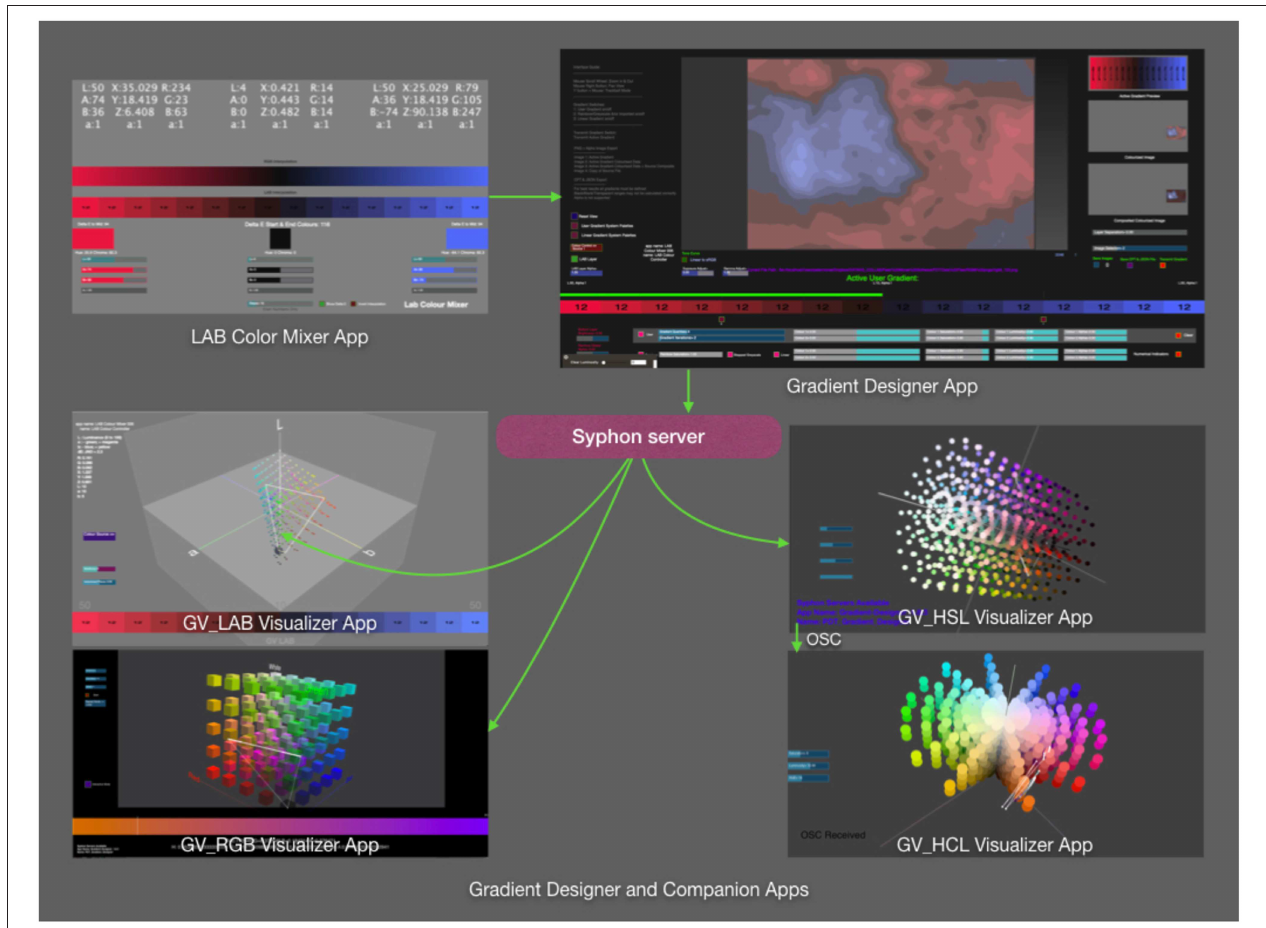
FIGURE 3 | GD Color Space Visualization Companion Apps. This figure illustrates the workflow relationship between the LAB Color Mixer App, Gradient Designer and the four color space visualization apps, GV_LAB, GV_RGB, GV_HSL, and